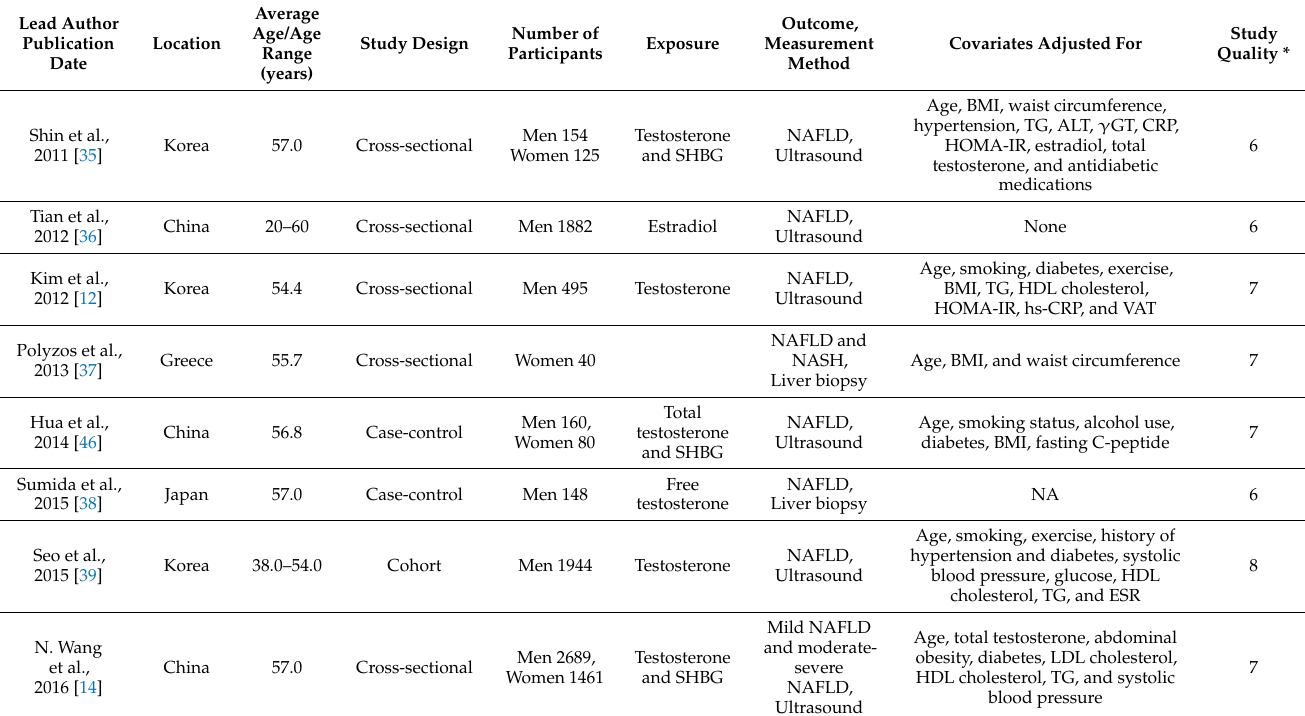
Figure 2. Flow chart of studies included in the systematic review and meta-analysis. Table 4. Characteristics of the included studies for